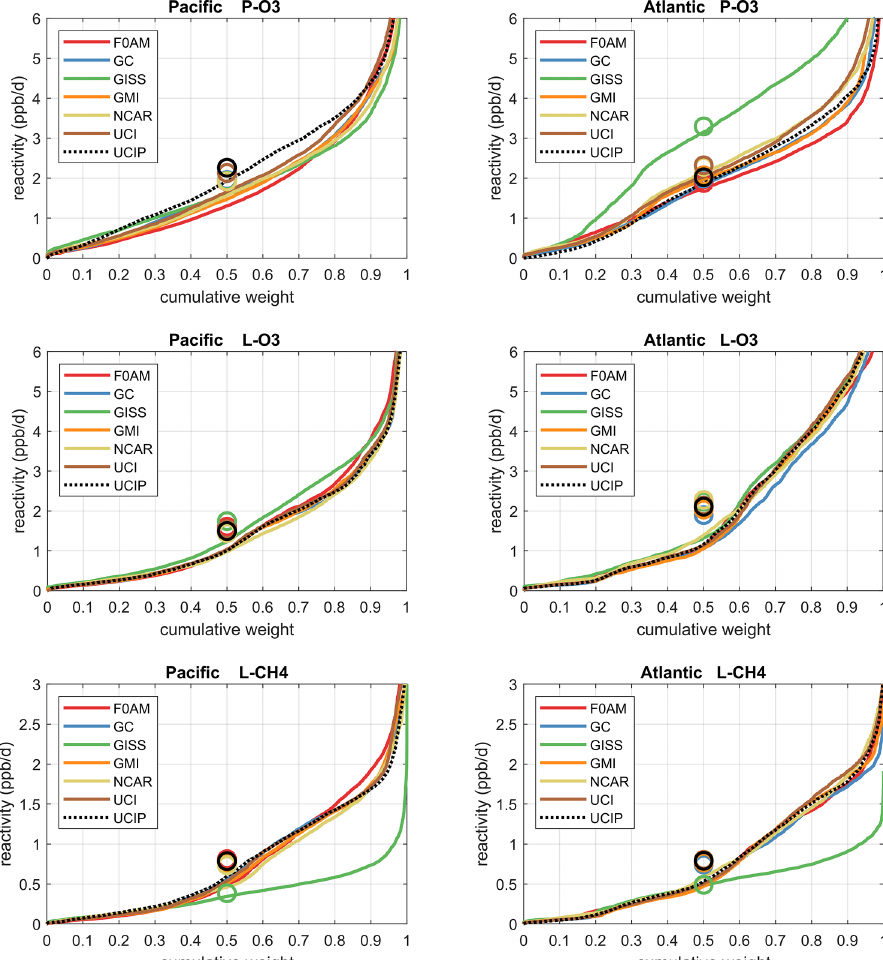
Figure 1. Sorted reactivities (P-O3, L-O3, L-CH4, ppb/d) for the Pacific and Atlantic domains of ATom-1. Each parcel is weighted; see text. The six modeled reactivities for MDS-0 using the standard RDS protocol are shown with colored lines, and the UCI calculation for MDS-2 using the new RDS ∗ protocol (HNO 4 and PAN damping, denoted UCIP) is shown as a dashed black line. The mean value for each model is shown with an open circle plotted at the 50th percentile. (Flipped about the axes, this is a cumulative probability density